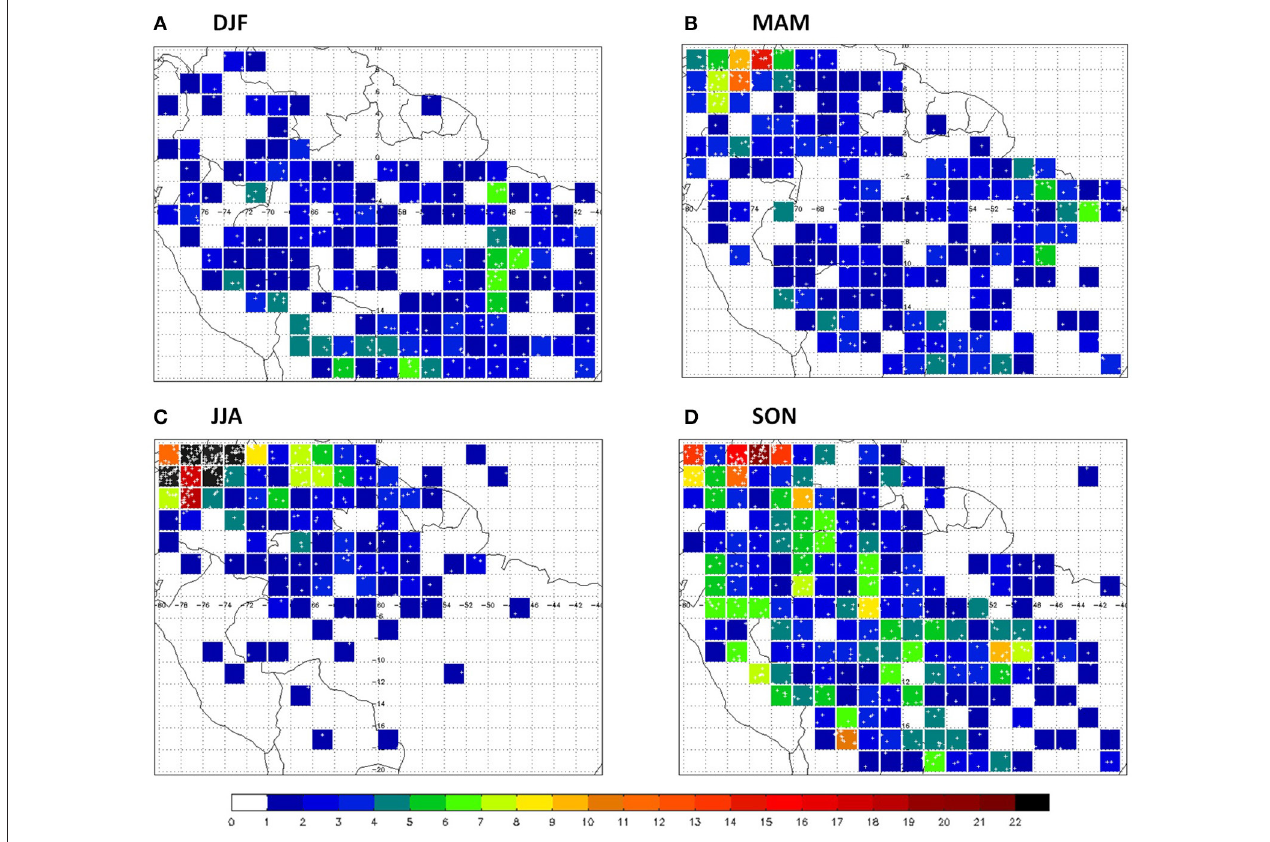
FIGURE 4 | Distribution of the number of potentially severe cases in subset 4 at a 2 ◦ resolution grid for the period 1998–2012 for: (A) December–January–February; (B) March–April–May; (C) June–July–August; (D)